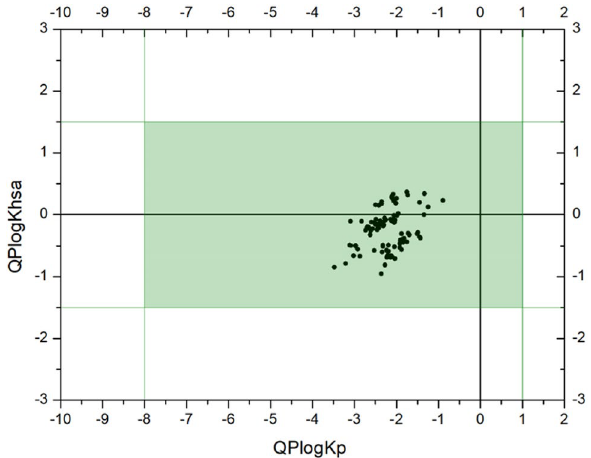
Figure 2. Graph showing the calculated parameters related to the biopermeability of compounds for humans: QPlogKp (predicted skin permeability, log Kp.), QPlogKhsa (prediction of binding to human serum albumin). The green area shows the normal range of